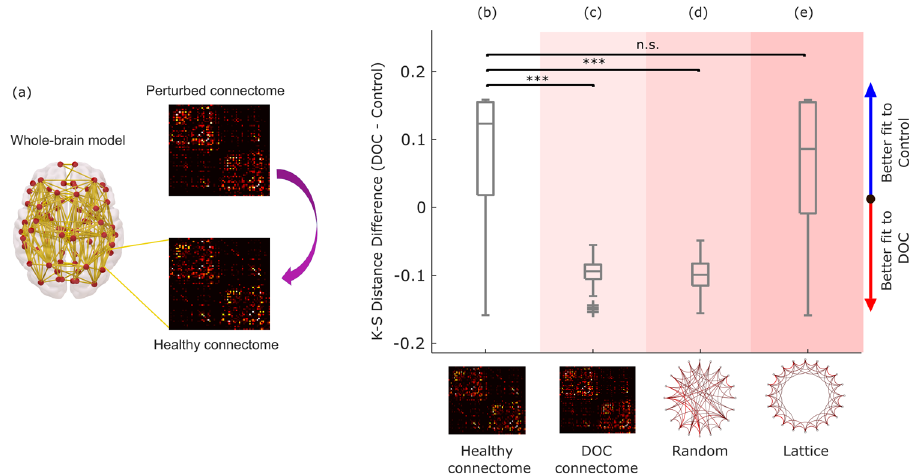
Fig. 4 Connectome replacement analysis with DOC connectome. a The original healthy connectome of the model is replaced with the group-average connectome obtained from diffusion MRI of n = 21 DOC patients, and the resulting model is used to generate n = 100 simulations. b – e Box-plots show the difference in model fi t (KS-distance) between the two conditions ( fi t to DOC patients ’ data minus fi t to healthy controls ’ data, over n = 100 simulations), for the initial model calibrated based on the healthy connectome ( b ), and after replacing the model ’ s initial connectome with either the DOC patients ’ empirical consensus connectome ( c ), or after rewiring the initial connectome into a random network ( d ), or into a regular (lattice) network ( e ). Middle line: median; box limits, upper and lower quartiles; whiskers, 1.5x inter-quartile range; “ + ” symbol indicates outliers; *** p < 0.001; n.s. Not signi fi cant ( p > 0.05) from t -test. Source data are provided in Supplementary Data 2. We replicated this result using an alternative version of the KS-distance, which in addition to the distribution of FCD values also takes into account the temporal lag between them (Supplementary Fig.